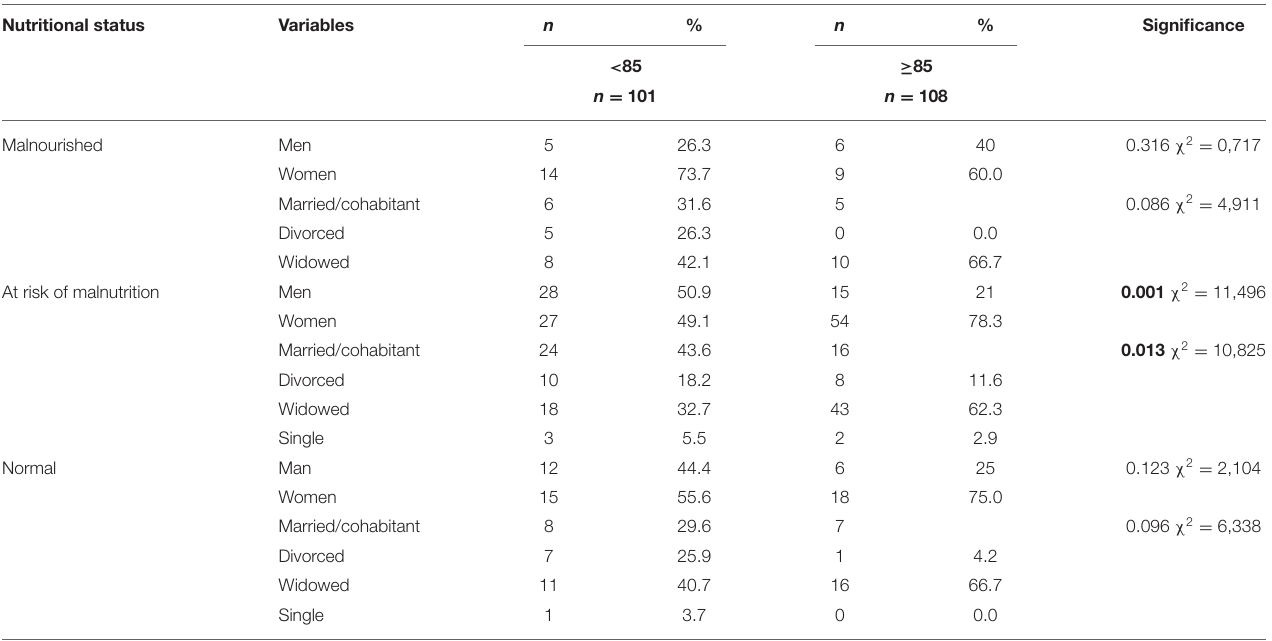
TABLE 3 | Participants’ nutritional status by age according to sex and marital status. Nutritional status